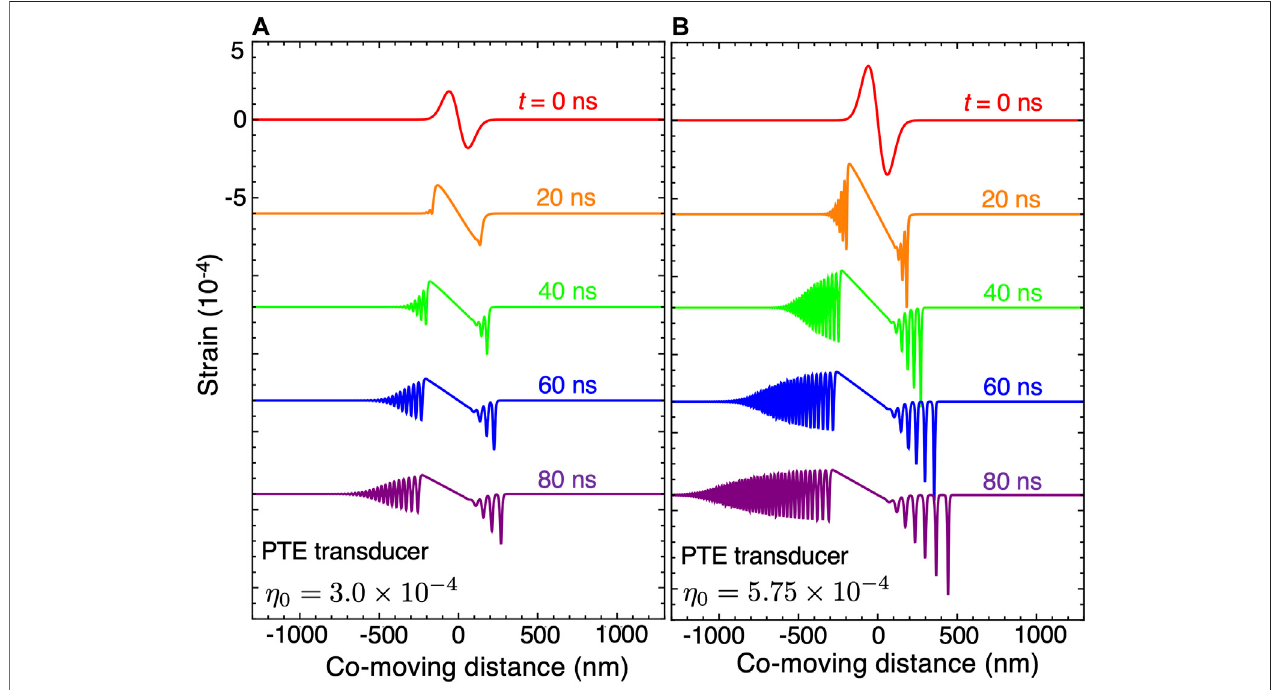
FIGURE 2 | Evolution of strain pulses generated in materials with conventional thermal expansion for initial strain amplitudes (A) η 0 (cid:1) +3.0 × 10 – 4 and (B) η (cid:1) +5.75 × 10 – 4 0